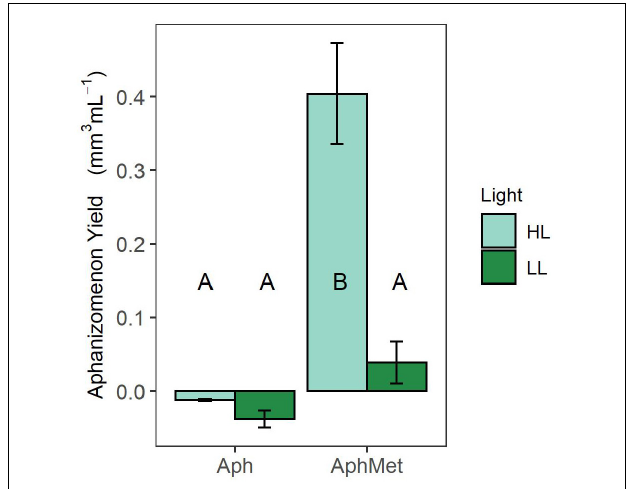
FIGURE 5 | Yield of cyanobacteria during the experiment. Bars represent the means ± 1 standard error ( n = 5 for each treatment).